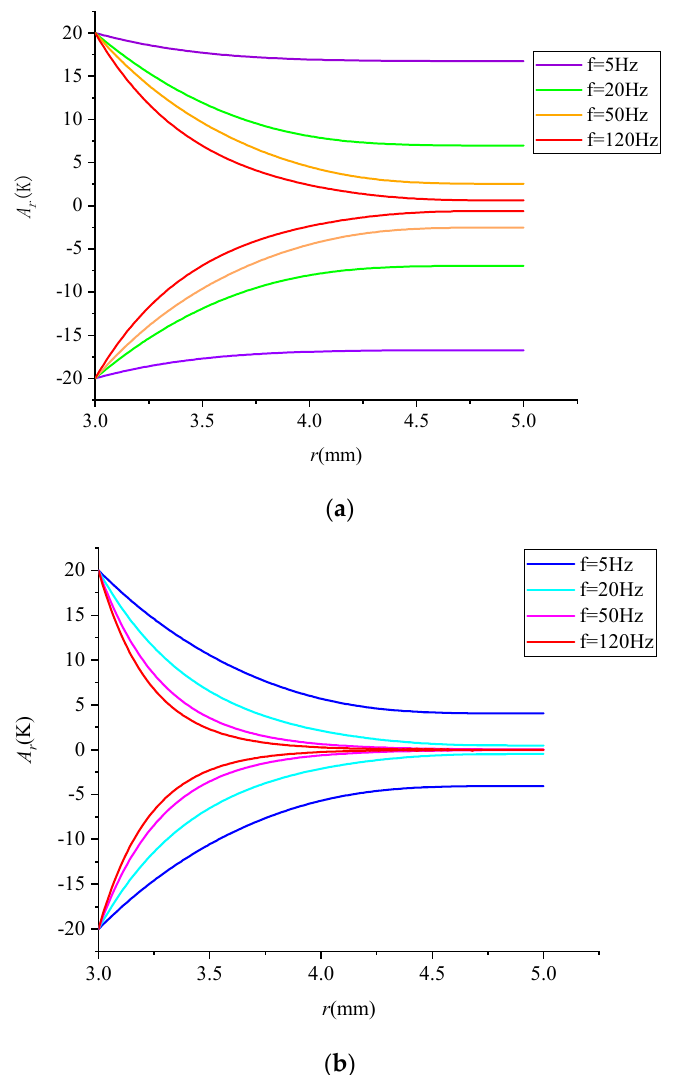
Figure 7. Distribution curve of A r – r temperature amplitude in wall thickness ( a ) aluminum alloy tube, r 1 = 3 mm, r 2 = 5 mm ( b ) carbon fiber tube, r 1 = 3 mm, r 2 = 5 mm.